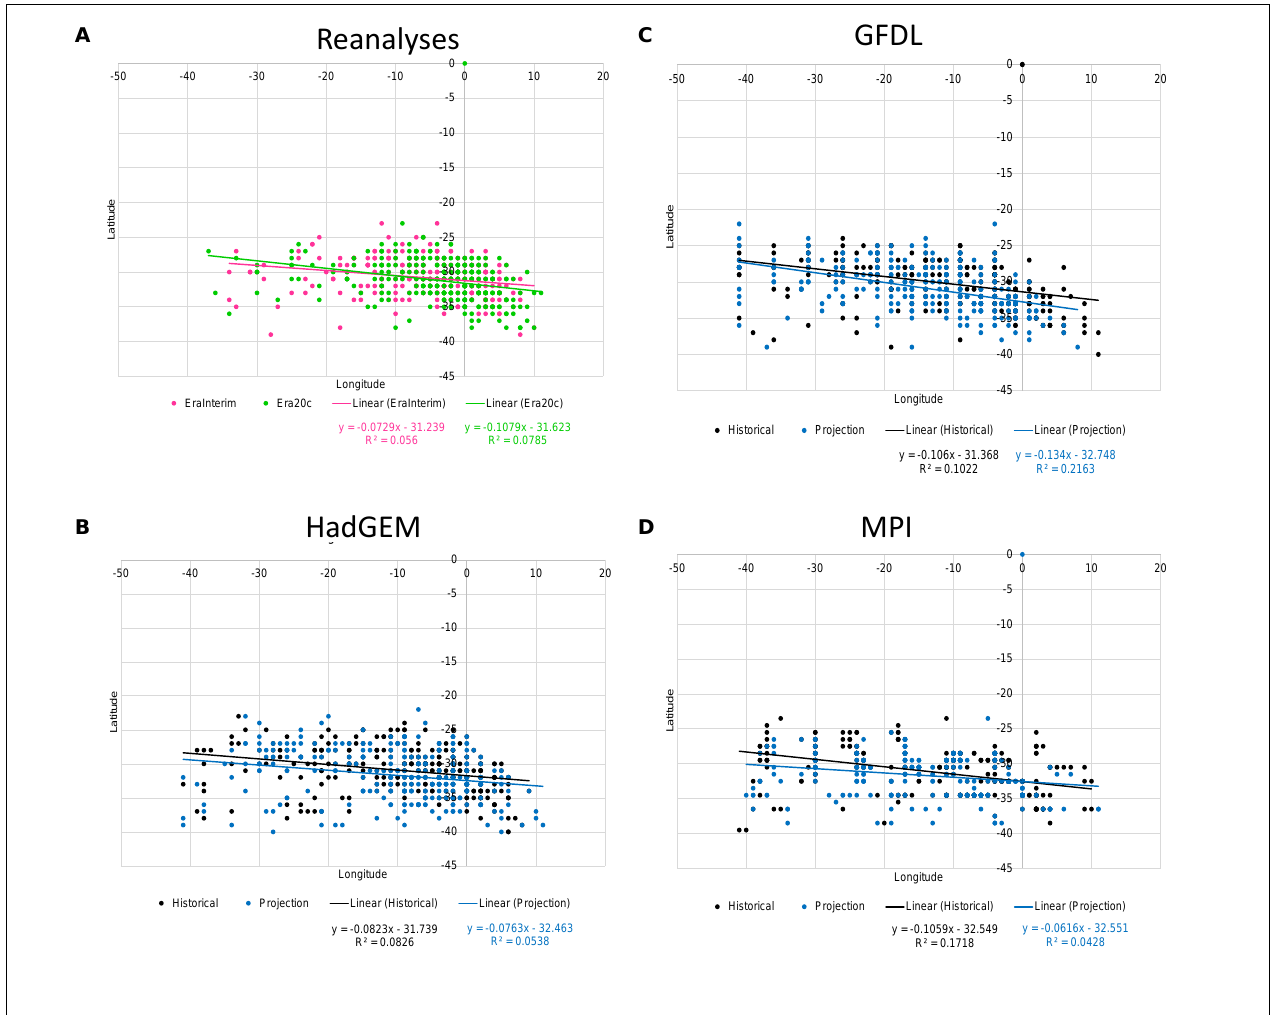
FIGURE 5 | Scatter diagram for monthly latitude and longitude of the SASA in the present and future climates from (A) reanalyses (only for present), (B) HadGEM, (C) GFDL, and (D) MPI. Regression equations are also shown in the plots.